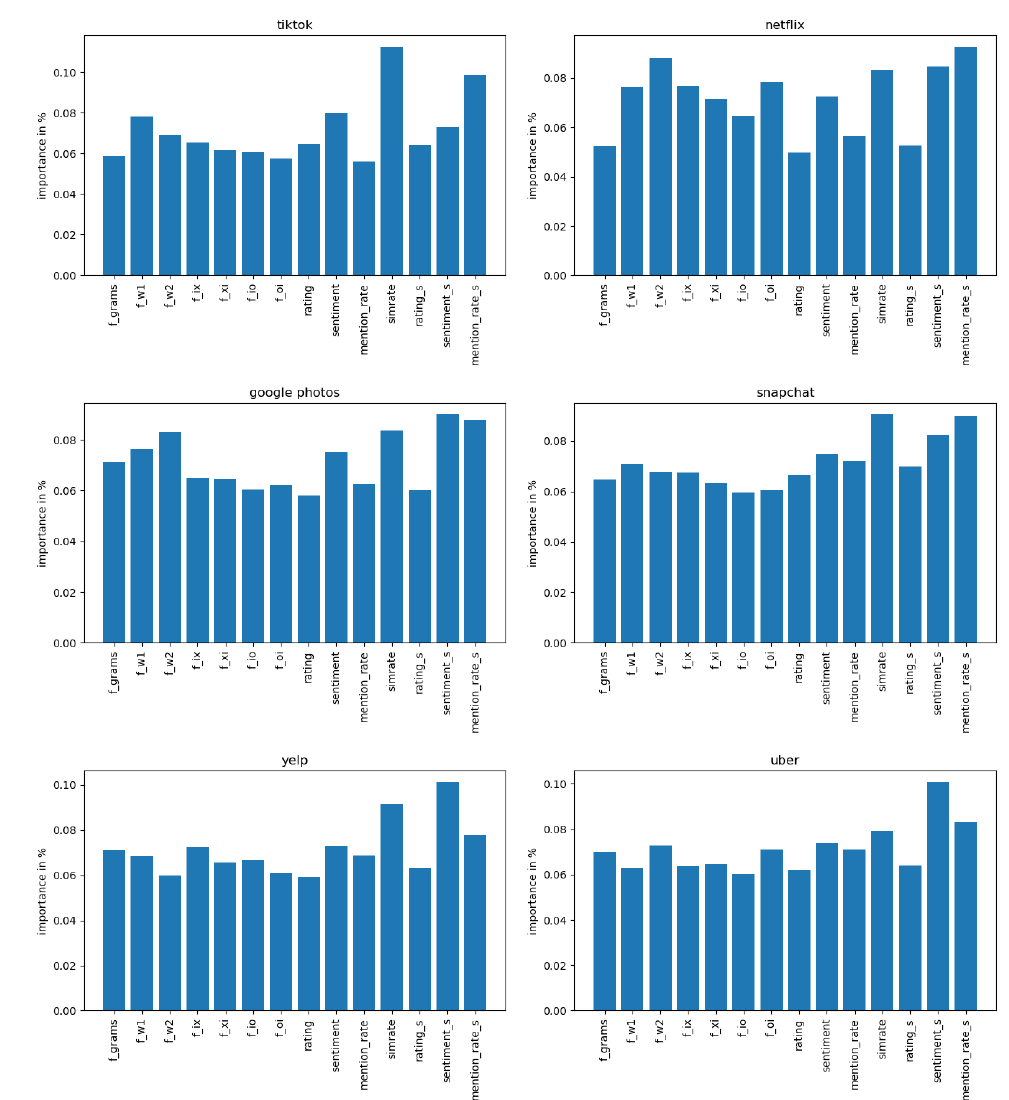
Figure 5. Feature importance for each